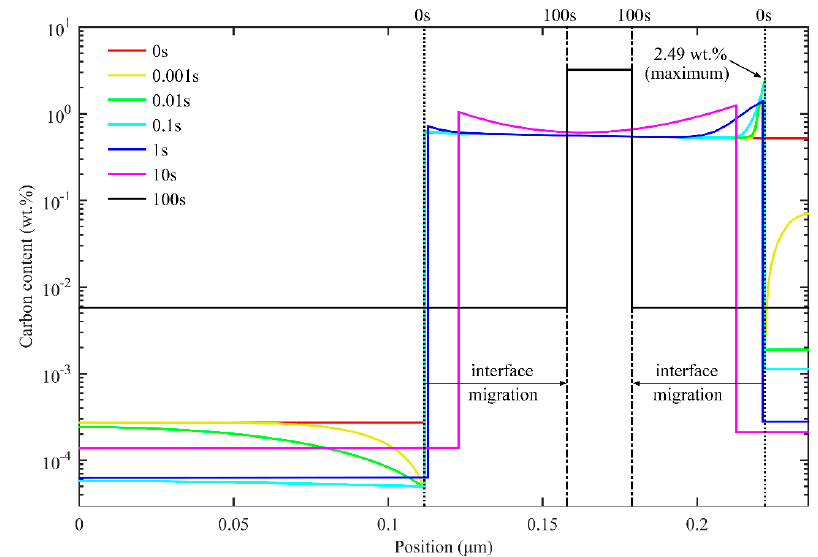
Figure 7. Carbon redistribution during the second partitioning at 350 ◦ C for 100 s after the process of first quenching to 325 ◦ C, first partitioning at 425 ◦ C for 10 s, and second quenching to 250 ◦ C (two-stage Q-P process).